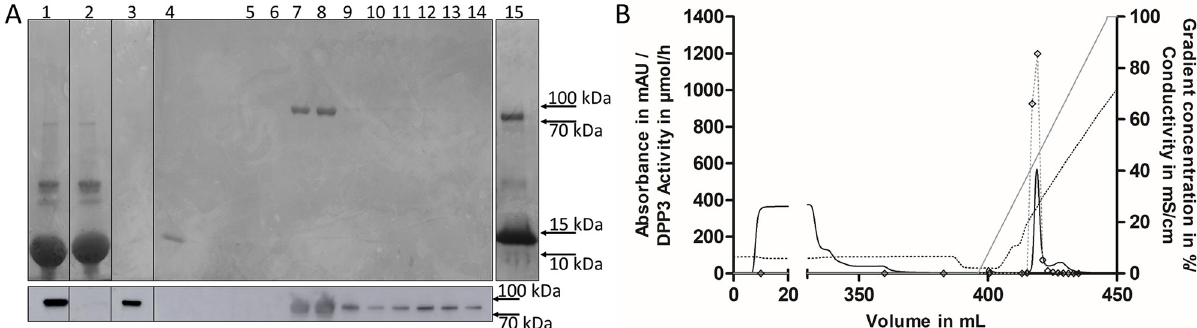
Fig 2. Coomassie staining of DPP3 purification fractions and chromatogram of DPP3-IEX purification. (A) Top: Coomassie staining of purification fractions on a 4–20% gradient gel. Bottom: Western Blot of purification fractions shown in A-top. Lane 1: Starting material in 1:10 dilution, Lane 2: IAP flow-through in 1:10 dilution, Lane 3: Combined IAP eluates in 1:10 dilution, Lane 4: Concentrated IEX flow-through in 1:20 dilution, Lanes 5–14: Fractions 12–21 from the IEX run in 1:20 dilution. Lanes 7 and 8 contain the main DPP3 fractions contributing to the elution peak in Fig 2B, Lane 15: undiluted and two-fold concentrated combined IAP eluates shown in lane 3. Protein ladder used: Spectra Multicolor Broad Range Protein Ladder (Thermo Fisher Scientific). (B) DPP3 containing fraction from the immuno-affinity purification (360 mL) were loaded on the Q-sepharose resin using the A¨kta Start sample pump (0–370 mL). After loading the column was washed with 5 CV of IEX-buffer 2 (370–395 mL). Elution of DPP3 was started by application of a NaCl gradient over a volume of 10 CV (395–445 mL). Activity in elution fractions was determined via DPP3-ECA. Solid gray line: salt gradient in %, solid black line: absorbance at 280 nm in mAU, dotted gray line with squares: Arg 2 -ßNA hydrolyzing activity in μ mol/h, dotted black line: conductivity in mS/cm.